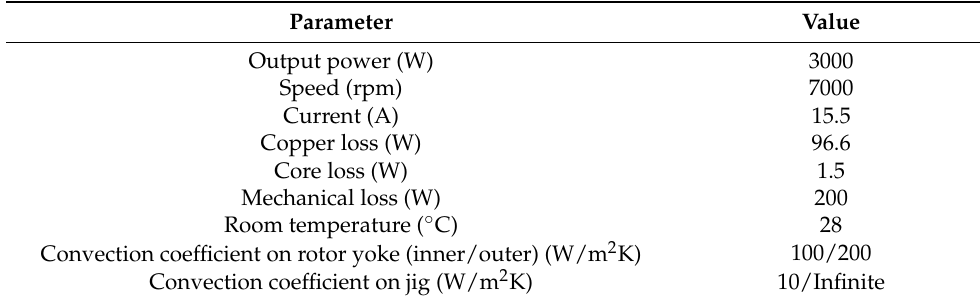
Table 5. Input parameters for the thermal analysis.